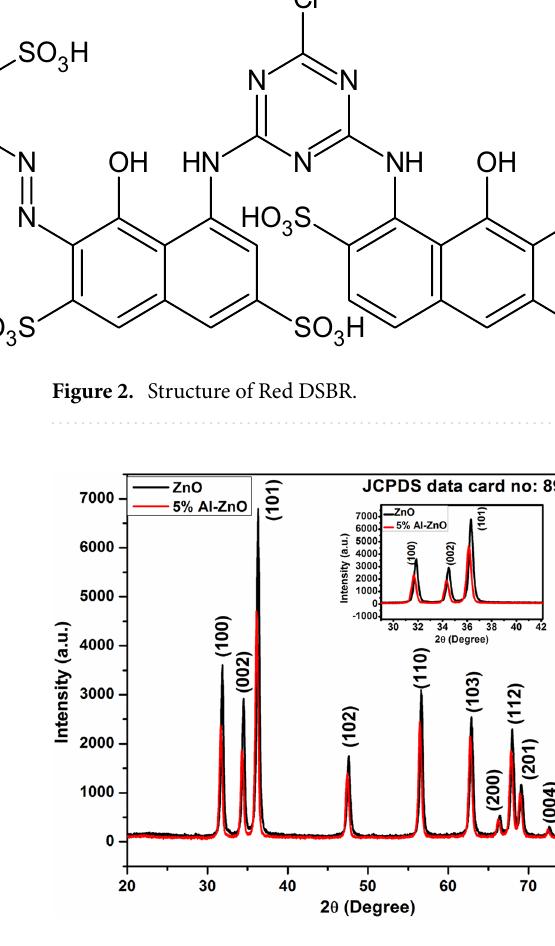
Figure 3. XRD patterns of ZnO and 5% Al-ZnO NFs. Inset shows the peak shifting character of the plane (100) (002) and (101) towards lower angle for Al-ZnO.